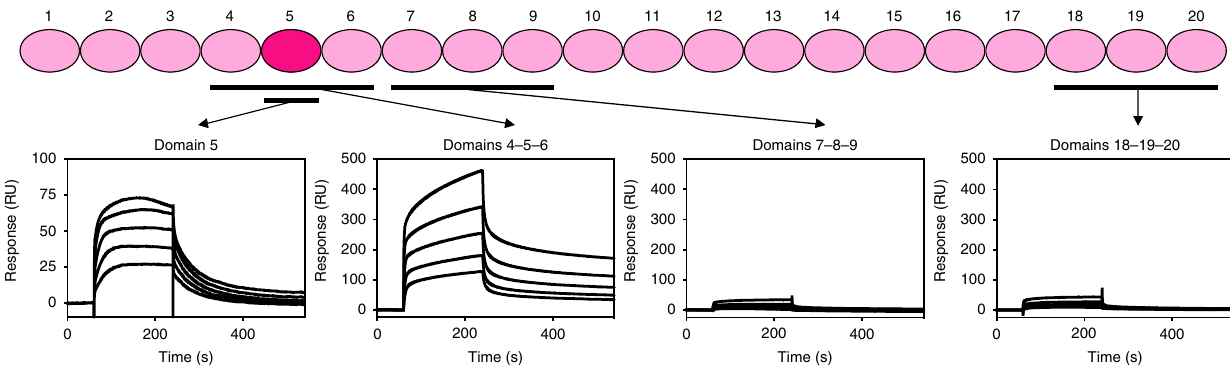
Fig. 2 FHR binds FH domain 5. Schematic of the 20 domains of bovine FH showing the domains that were assessed for binding to FHR with the SPR- binding data for each shown below. C-terminally biotinylated FHR (400 RU) was bound to a streptavidin chip and twofold dilutions of FH domains 4-5-6 (1.5 μ M highest concentration), 7-8-9 (30 μ M highest concentration), 18-19-20 (40 μ M highest concentration), and domain 5 alone (5 μ M highest concentration) were analysed. Source data are provided as a Source Data fi